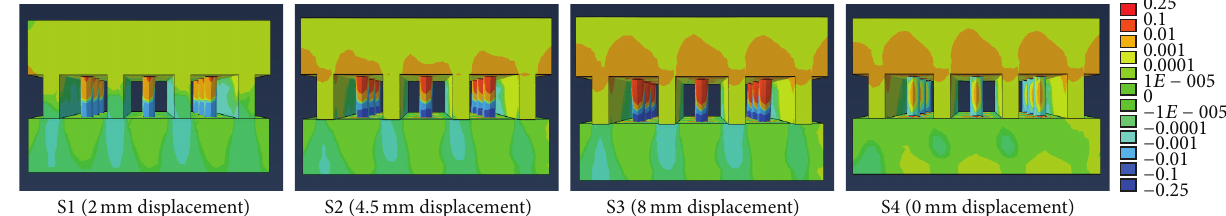
Figure 17: Axial strain component (LE22) contours distributed over the SMA-0.10 model according to individual loading steps (Unit: rad).